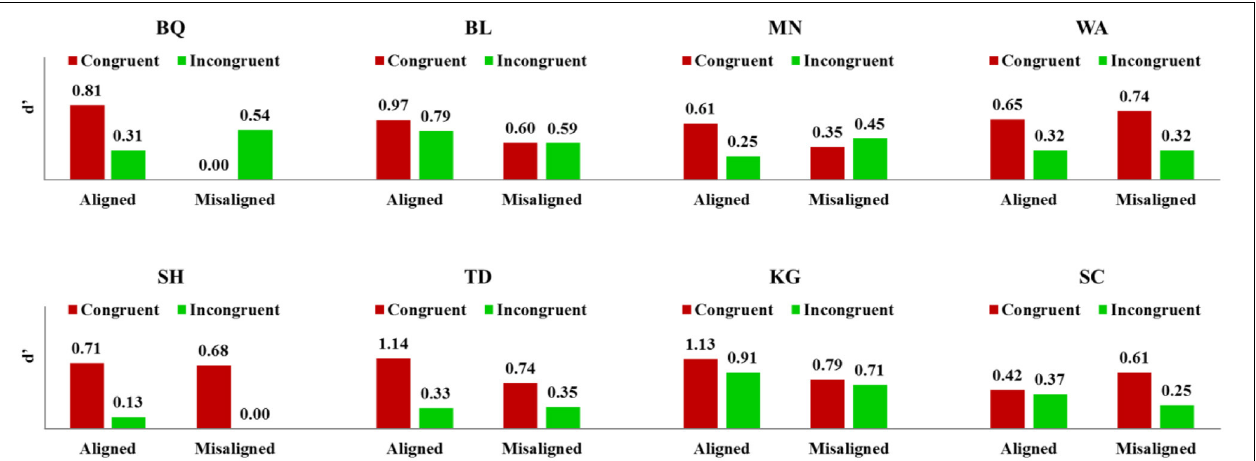
FIGURE 4 | Performance ( d (cid:2) ) for each individual CP participant on congruent and incongruent trials for aligned vs. misaligned faces where the cued half was collapsed across visual fields (note that the y-axis varies across participants).